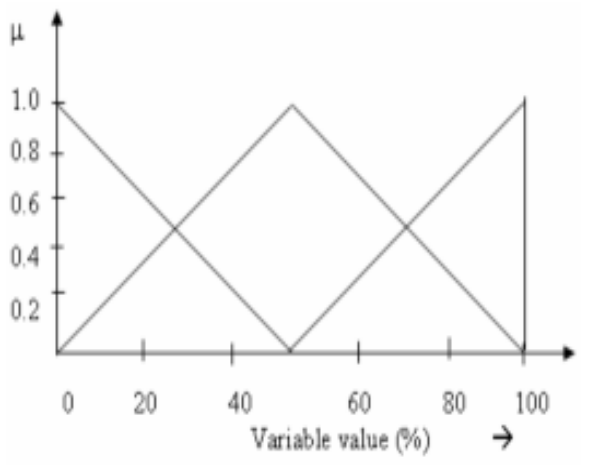
Figure 7: Fuzzy Membership functions